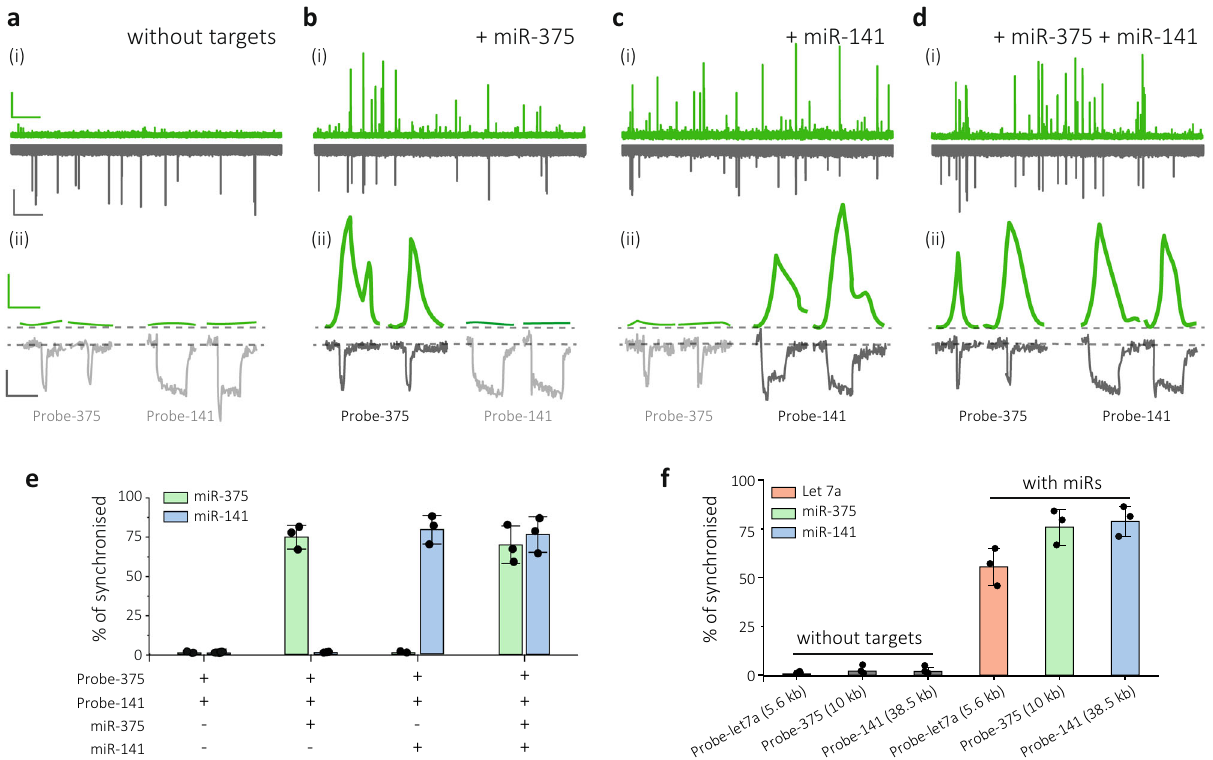
Fig. 3 Single-molecule multiplexed detection using synthetic miRNAs. a – d Intensities-time traces (i) and representative events (ii) for the translocation of a Probe-375 (10 kbp) and Probe-141 (38.5 kbp) on their own, b Probe-375 and Probe-141 in the presence of miR-375-p, c Probe-375 and Probe-141 in the presence of miR-141-3p, and d Probe-375 and Probe-141 in the presence of both miR-375-3p and miR-141-3p. Scale bar in (i): photon trace (green), vertical, 100 counts/ms, horizontal, 3 s; current trace, vertical, 30 pA, horizontal, 3 s. Scale bar in (ii): photon trace (green), vertical, 100 counts/ms, horizontal, 5 ms; current trace, vertical, 25 pA, horizontal, 5 ms. e Histograms summarising the ratio of synchronised events based on the data obtained from a – d . f Histograms for the synchronisation ratio for 3 miRNA populations. All DNA carriers and miRNAs were used at a concentration of 10 pM. The translocations were performed in 100 mM KCl buffer (5 mM MgCl 2 , 10 mM Tris-HCl, 1 mM EDTA, pH = 8.0) at an applied potential bias of − 300 mV. Laser power was 90 ± 4 µ W. The error bars in e and f represent the standard deviation measured from 3 different nanopore sensors ( n = 3). Data are presented as mean ± s. salt gradient of 40 mM/400 mM ( cis/trans ) and a lower molecular probe concentration of 1 pM. As shown in Supplementary Fig. 12, an almost 8-fold increase in capture rate was observed (from 0.15